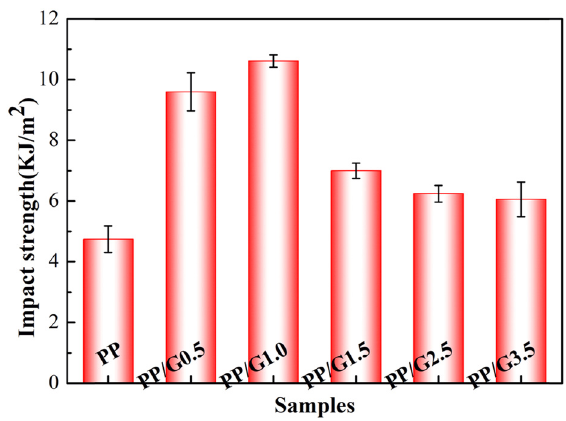
Figure 5: Impact strength of neat PP and PP/GNP nanocomposites.